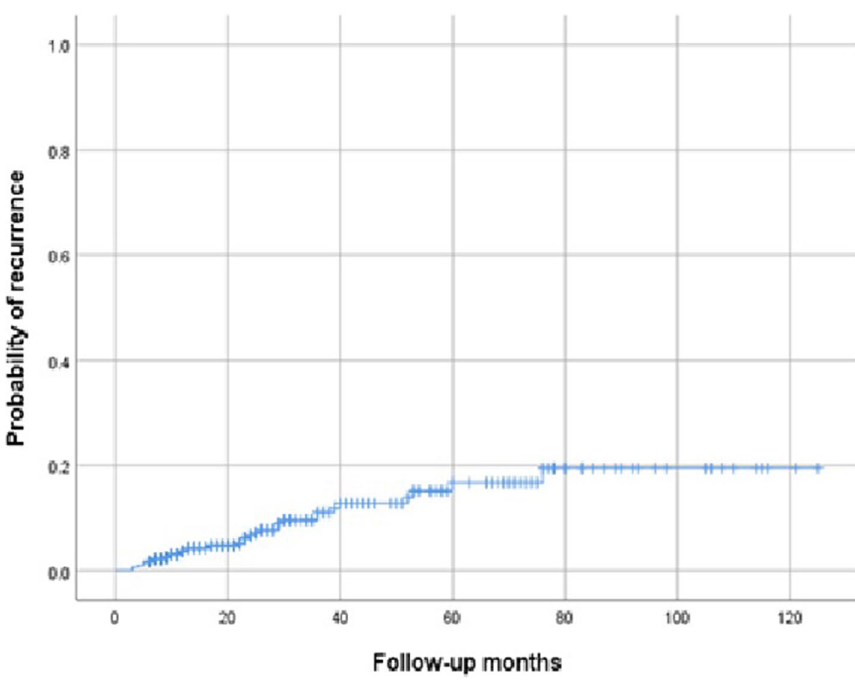
Figure 2. Cumulative recurrence of endometrioma after conservative ovarian cyst enucleation in women with 40–49